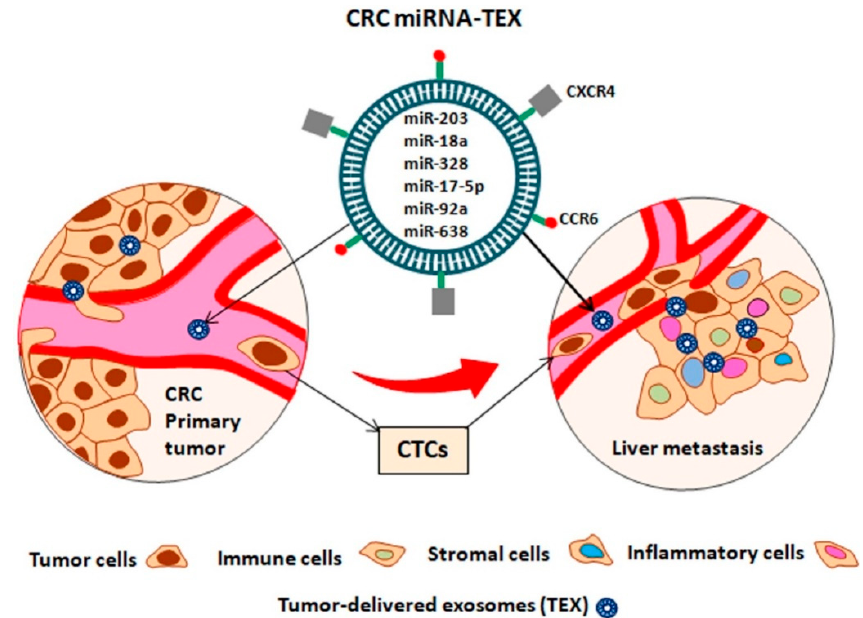
Figure 3. CRC metastasis in the liver through CRC circulating tumor cells (CTCs), mediated by miRNAs transported by CRC-delivered exosomes (miRNA-TEX). CXCR4 and CCR6 chemokine receptors are responsible for liver organotropism of miRNA-TEX, while the miRNAs released in the liver are responsible for preparing the secondary pre-metastatic niche by inducing the pro-inflammatory and pro-tumorigenic signals.